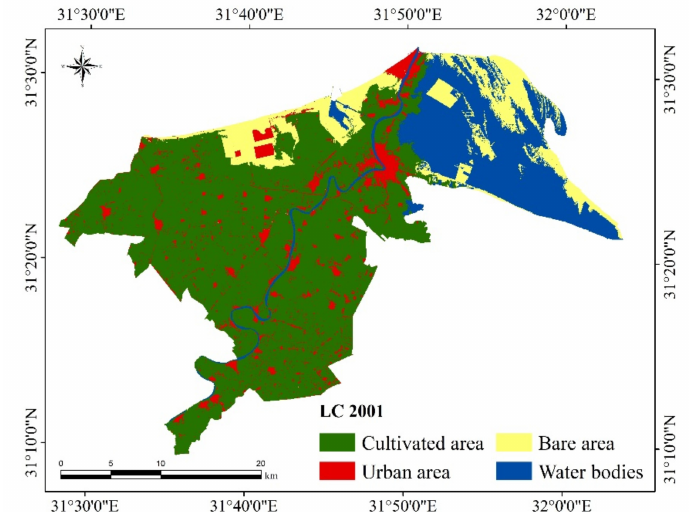
Figure 4. LULC of Damietta governorate at